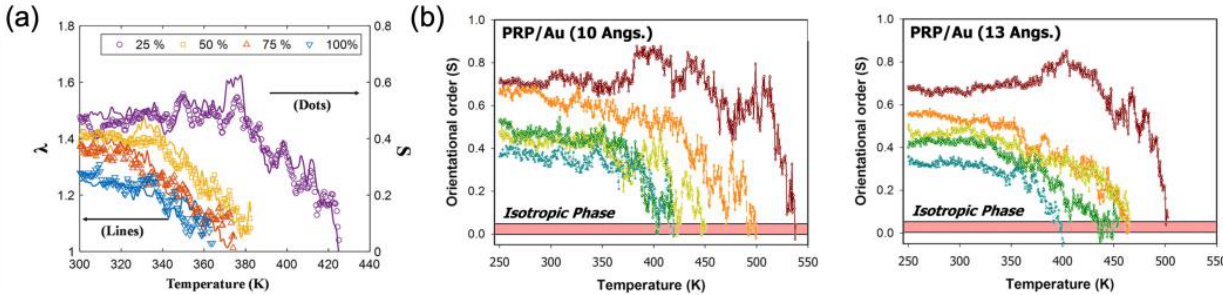
Figure 7. Heat-induced order collapse and the phase behavior of LCNs observed through molecular dynamics simulations: ( a ) correlations of the orientational order S and uniaxial shrinkage λ for the given temperature that are modulated via changing isomerization percentage (Adapted permission from Ref. [23]. 2016, Chung, H. et al.); ( b ) effect of incorporated metallic (Au) nanoparticle to the order collapse, and its dependence on the size of the particle (Adapted with permission from Ref. [79]. 2016, Choi, J. et